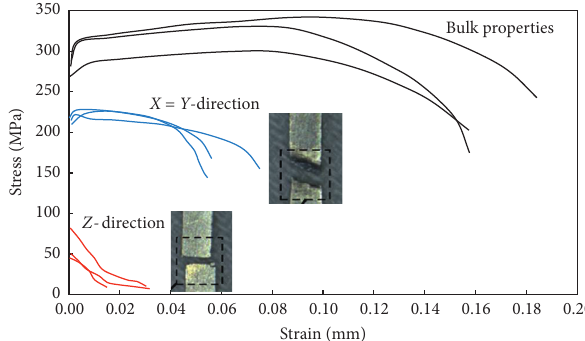
Figure 15: Typical engineering tensile curves for the UAM-pro- duced specimens in comparison with bulk commercial alloy (adopted from